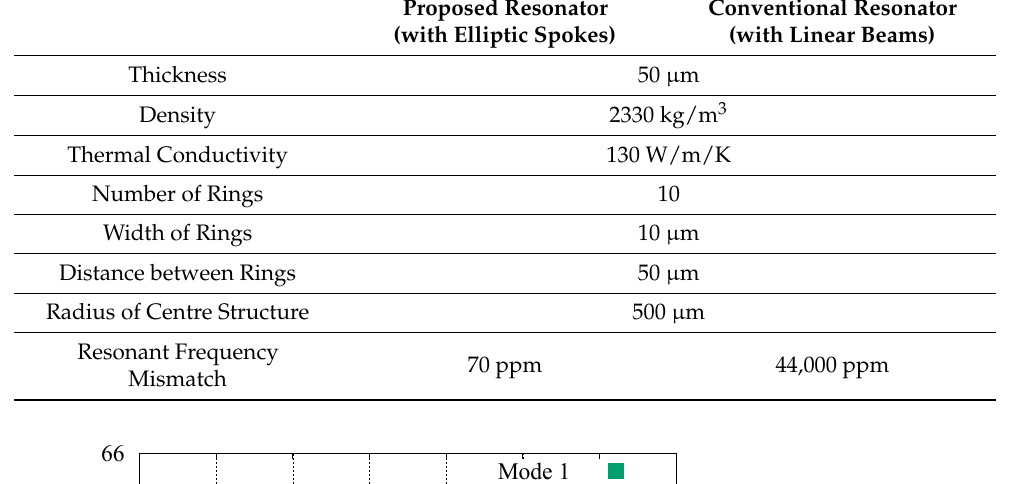
Figure 4. <100> mode shapes deformation in FEM simulation, the distortions of 45° segments are weakened in ( b ) proposed resonator with elliptic spokes, compared with ( a ) conventional resonator with linear beams.